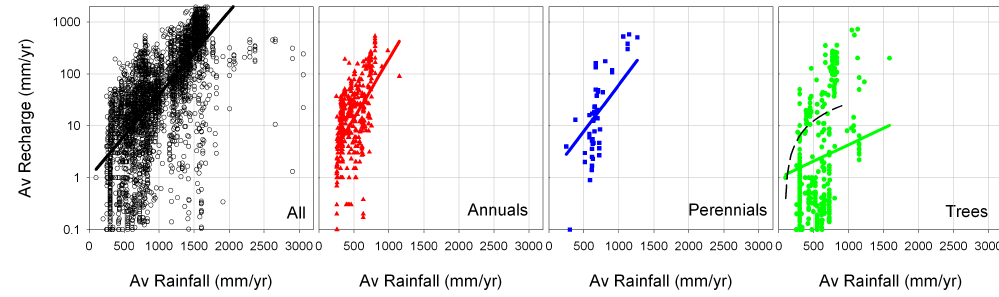
Fig. 6. The relationship between rainfall and recharge for each vegetation type. The black dashed line on the trees plot is the relationship between rainfall and recharge for natural areas developed by Scanlon et al. (2006). The class “all” is all the recharge estimates irrespective of vegetation